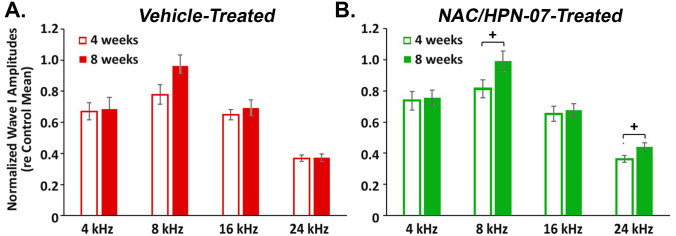
Time-dependent effects of treatment on ABR threshold sensitivity.After initial threshold stabilization, the reduced amplitudes of ABR wave I progressively recovered with increasing post-blast exposure time in the NAC/HPN-07 therapeutic treatment group (B.) but not in the vehicle treatment group (A.). ABR wave-I amplitudes were normalized with respect to mean values in age-matched, unexposed naïve controls. Mean (± SE) amplitudes in response to tone bursts at 80 dB SPL are shown, where n = 34–40 ears/group. Data were obtained at 4 and 8 weeks after blast exposure, respectively. Statistical significance was determined by paired t-test with Holm-Bonferroni correction: +
p < 0.05, the simple effect of time at 8 and 24 kHz.